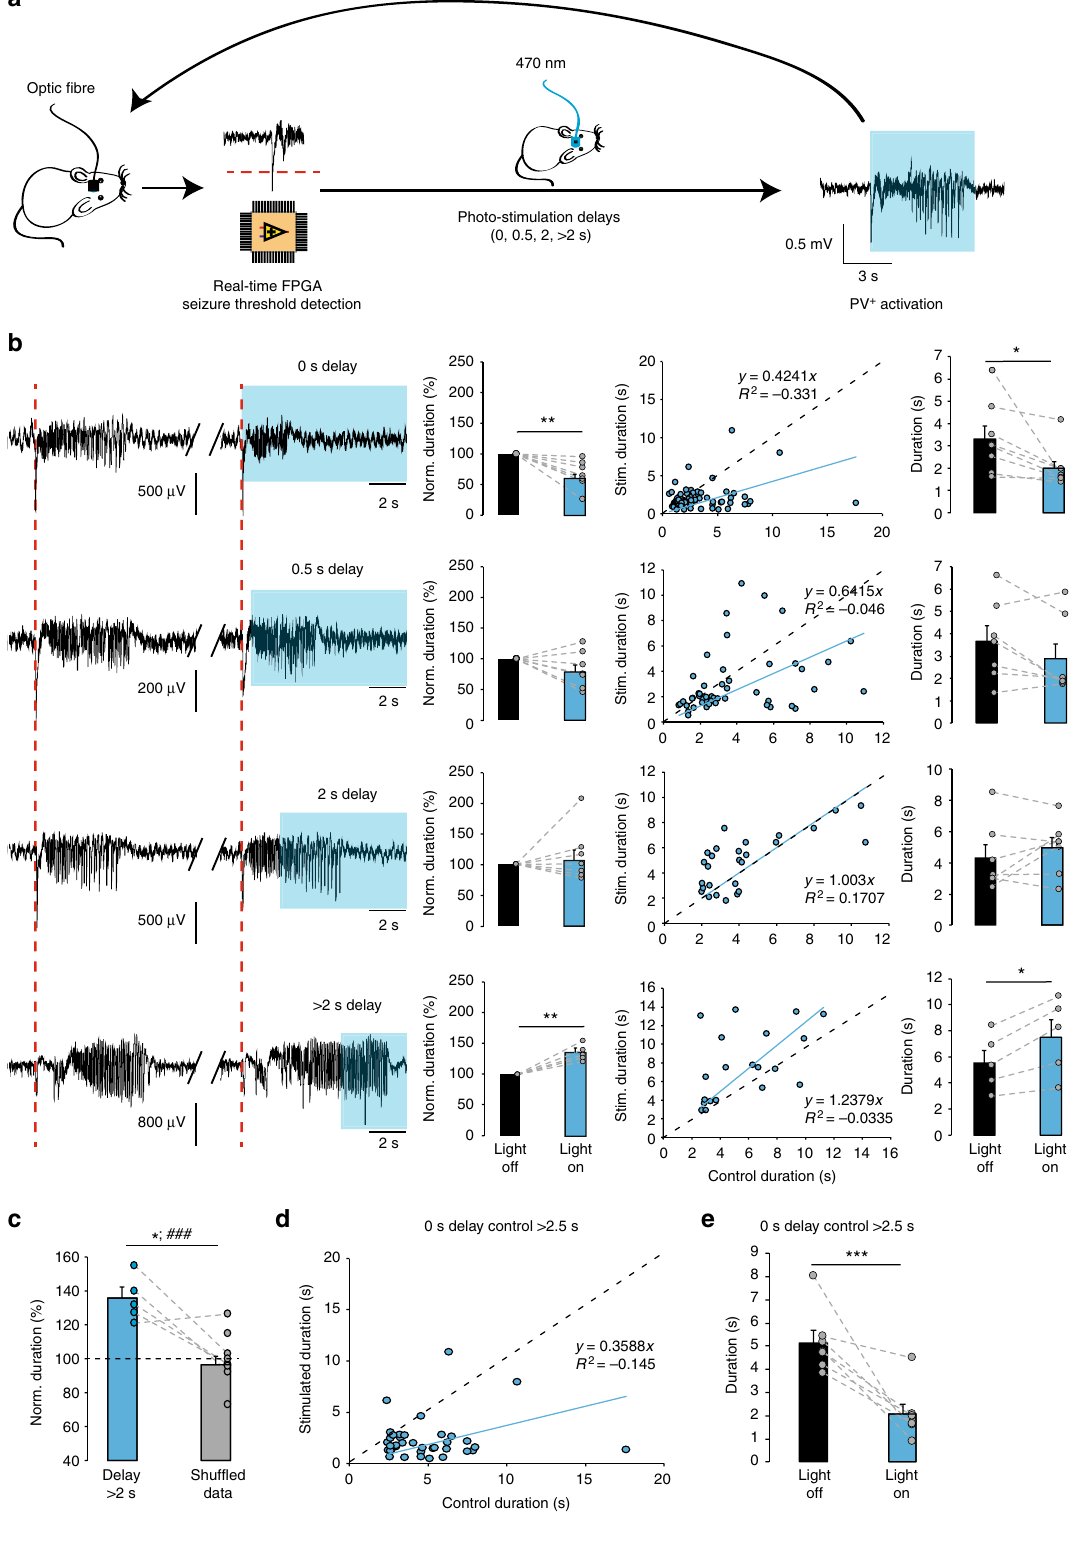
KCC2 overexpression prevents pro-ictal action of PV + cells . Activity-induced intracellular chloride accumulation and a con- sequent depolarizing shift of the GABA A reversal potential ( E GABA ) have been suggested to underlie the generation